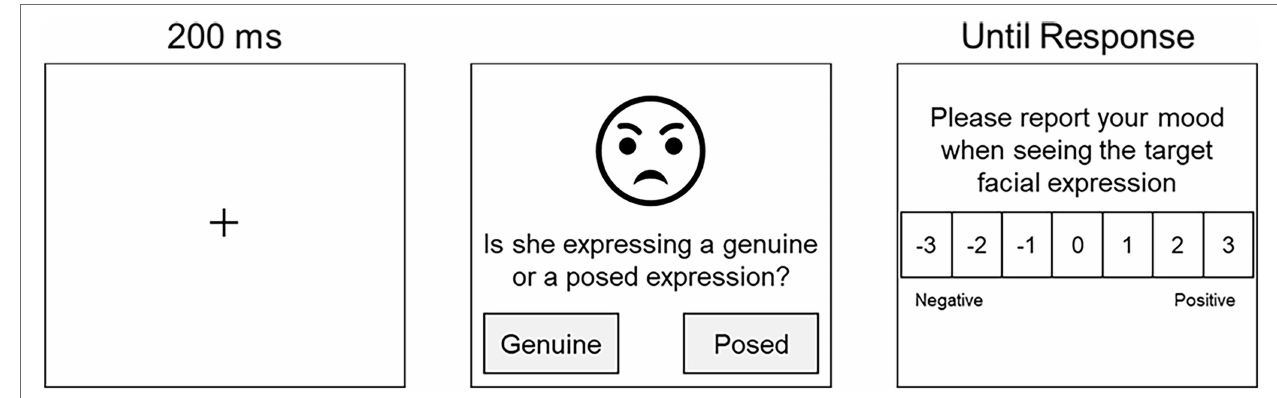
FIGURE 2 | Schematic diagram of a typical